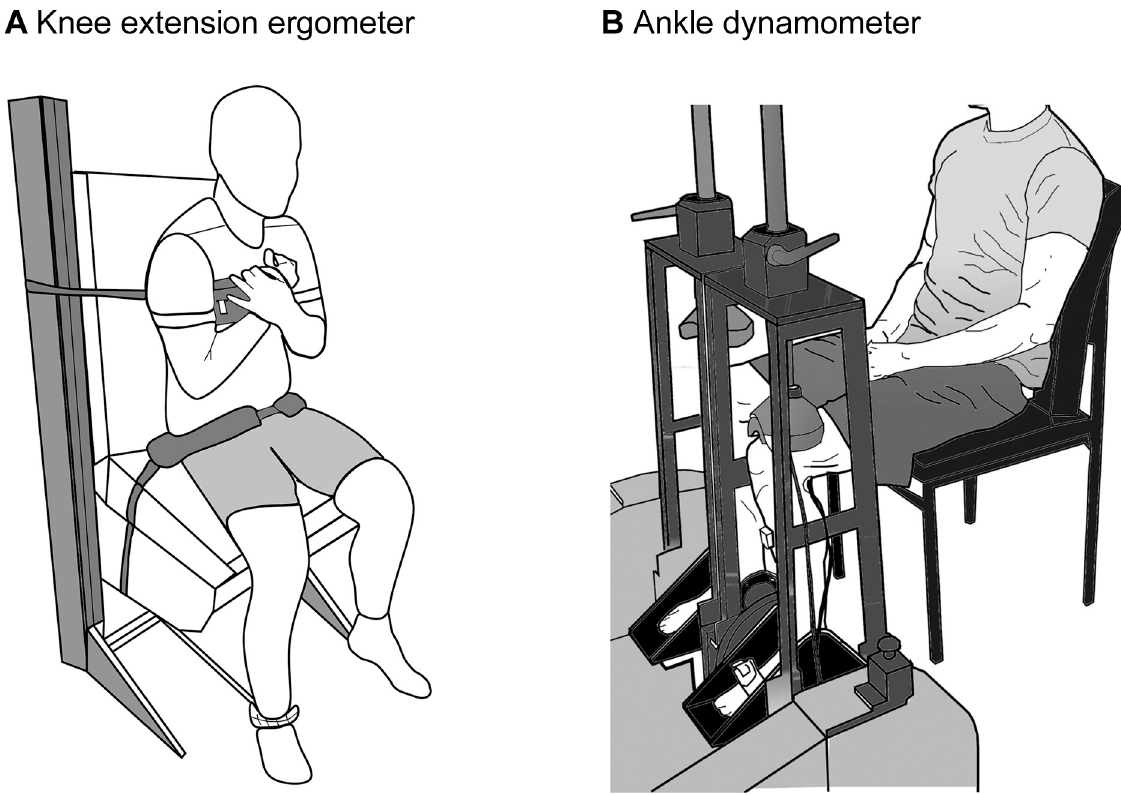
Fig 2. Ergometer and dynamometer used to test isometric leg strength. (A) Custom-made ergometer for the isometric maximal voluntary contraction during knee extension. The participant’s left ankle was attached to the ergometer’s lever arm about 3 cm above the lateral malleolus. Adjustable straps and pads on the chest and hip were used to minimize extraneous body movements. (B) Custom-made ankle dynamometer for the isometric maximal voluntary contraction during plantar flexion. The participant’s foot was fixed to the bottom plate with a strap to prevent plantar extension. The position of the knee was fixed with a clamp to prevent the lifting of the heel. Figure adapted with permission from Ku¨mmel et al., [24].